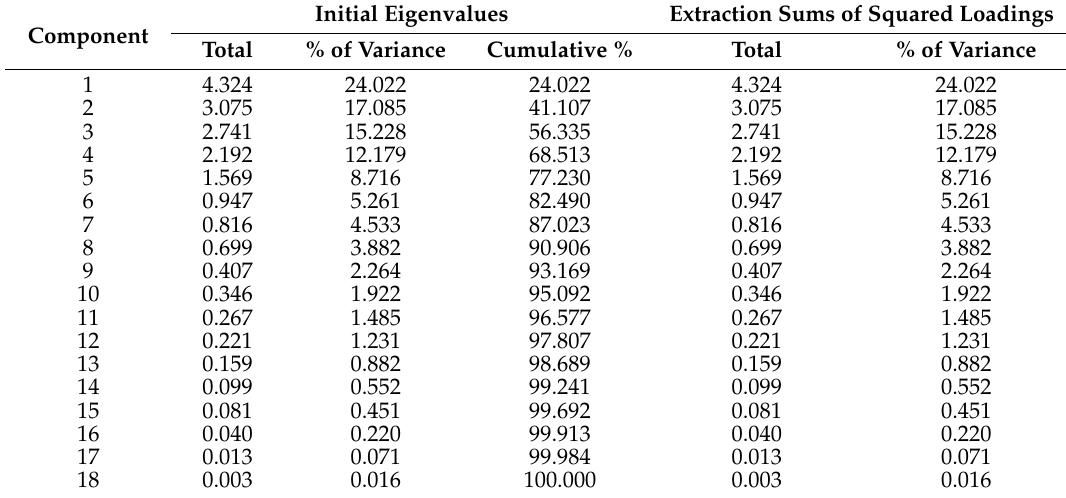
Table 2. Total Variance